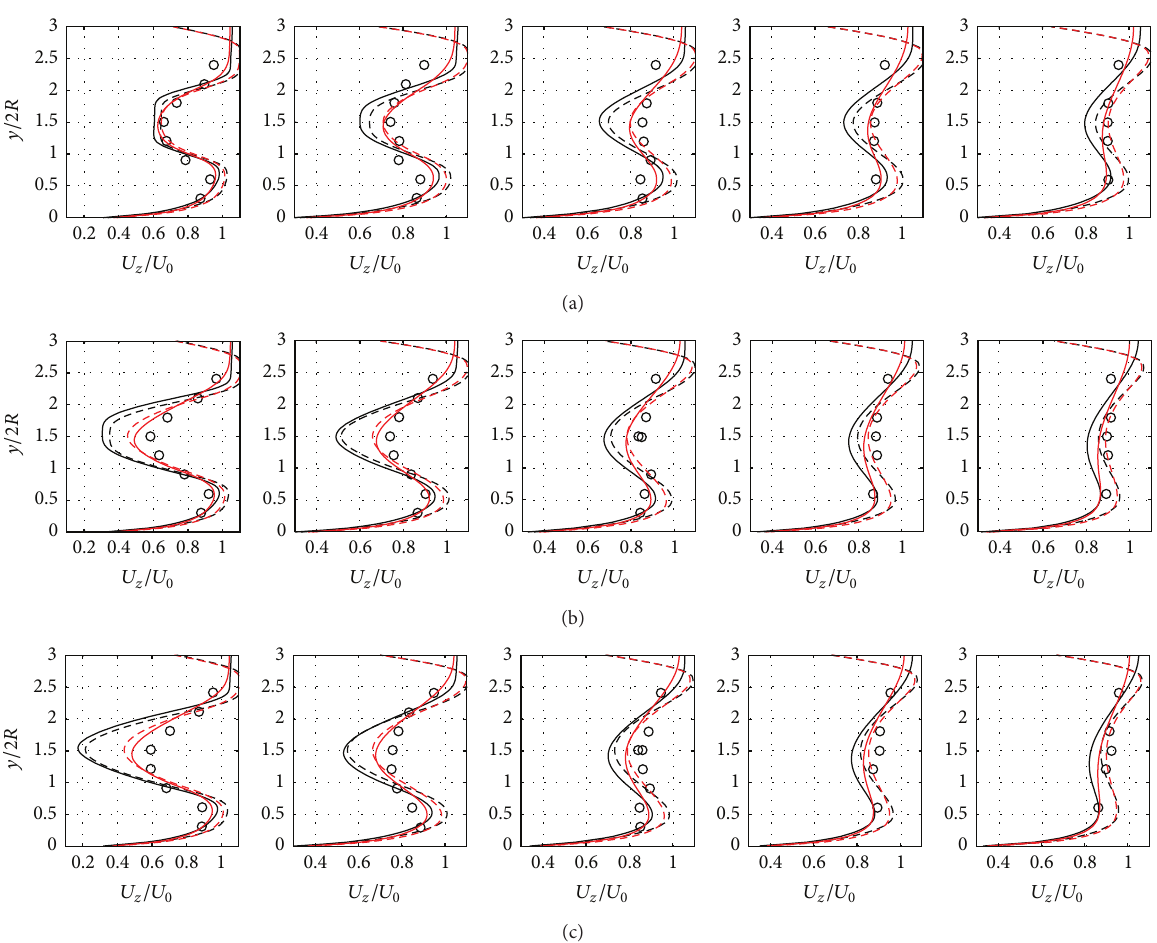
Figure 7: Normalized velocity of the channel (solid line), duct (dashed line), and experimental data ( ⃝ ) [11] at different 𝐶 𝑇 values of (a) 0.61, 0.62, (b) 0.86, 0.91, and (c) 0.97, 0.99 for this study and the experiment study, respectively [11]. The inlet 1 simulations are shown in black and inlet 2 simulations are in red. Each figure represents the distance downstream of the disc corresponding to 8𝑅 , 14𝑅 , 22𝑅 , 30𝑅 , and 40𝑅 ,